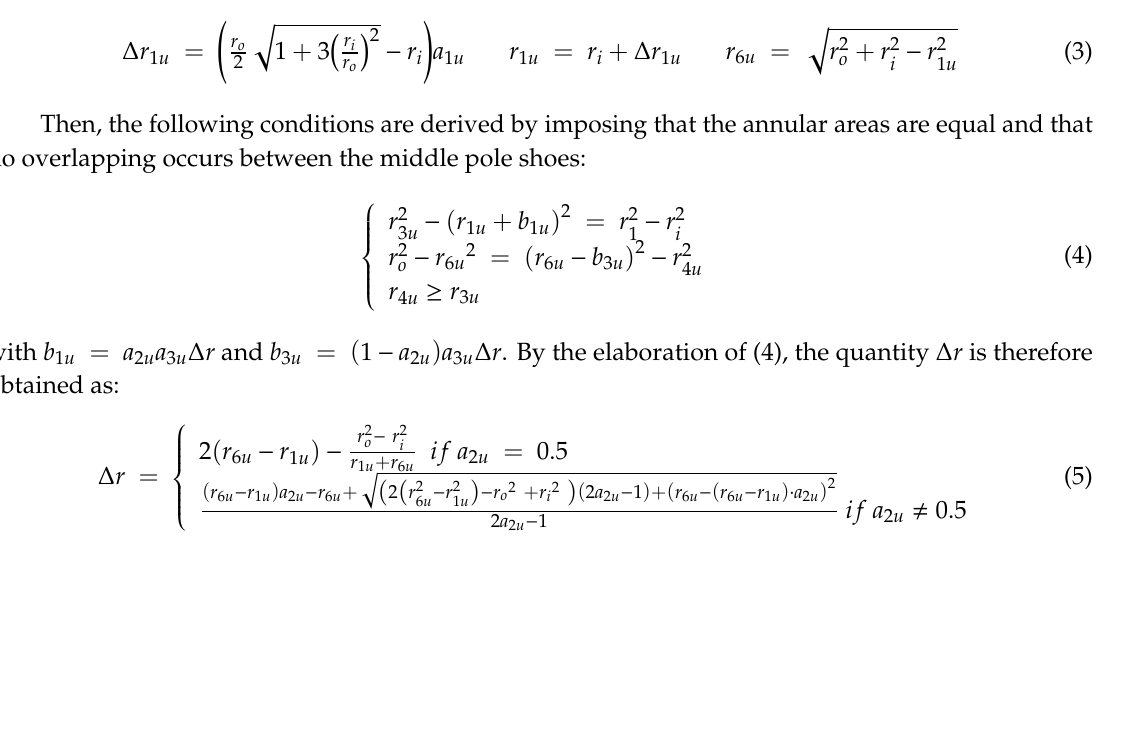
Figure 7. Force comparison between the coil supply strategies; A, B, C, D: excitation polarity represented in Figure 6; B1: excitation polarity as in B at a reduced air-gap length.